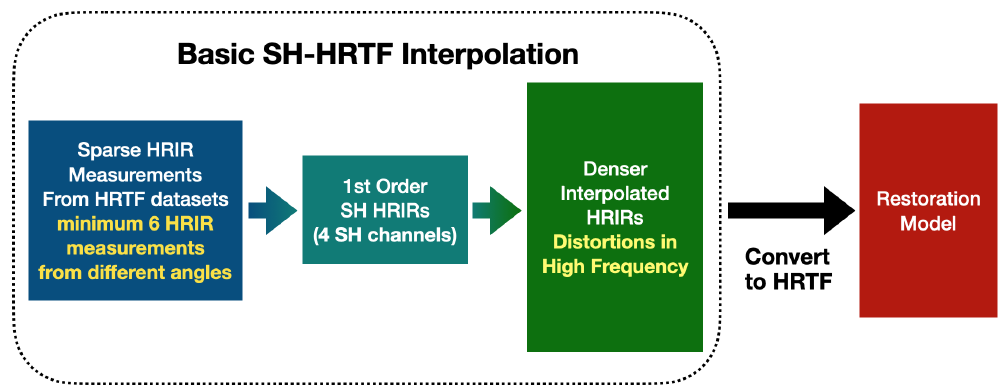
Figure 1. An overview of the proposed method wherein a model was trained to reconstruct the distorted high frequency information in the SH-interpolated